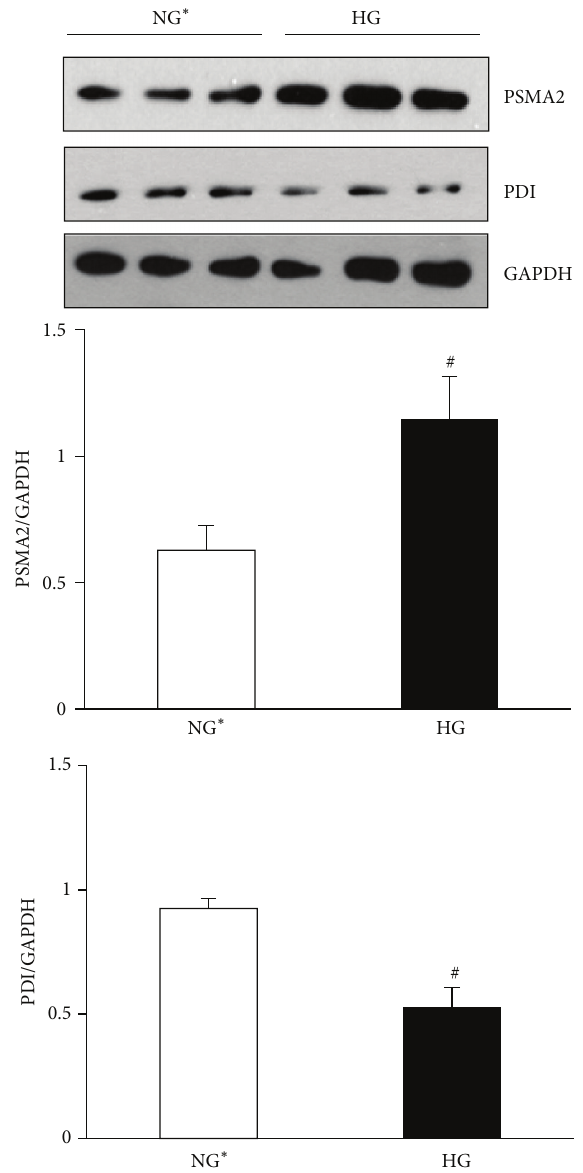
Figure 6: Correlative validation of 2DE results for the regulation of pathways involved in proteostasis. Immunoblot analysis of PSMA2 and PDI from mesangial cells cultured for 2h in HG or NG ∗ medium. Expression of PSMA2 increased whereas PDI decreased following 2h HG. Bar graphs, densitometric quantitation of PSMA2 orPDInormalizedtoGAPDHforeachlane.Dataareaverage ± SEM # 𝑝 < 0.05 versus NG ∗